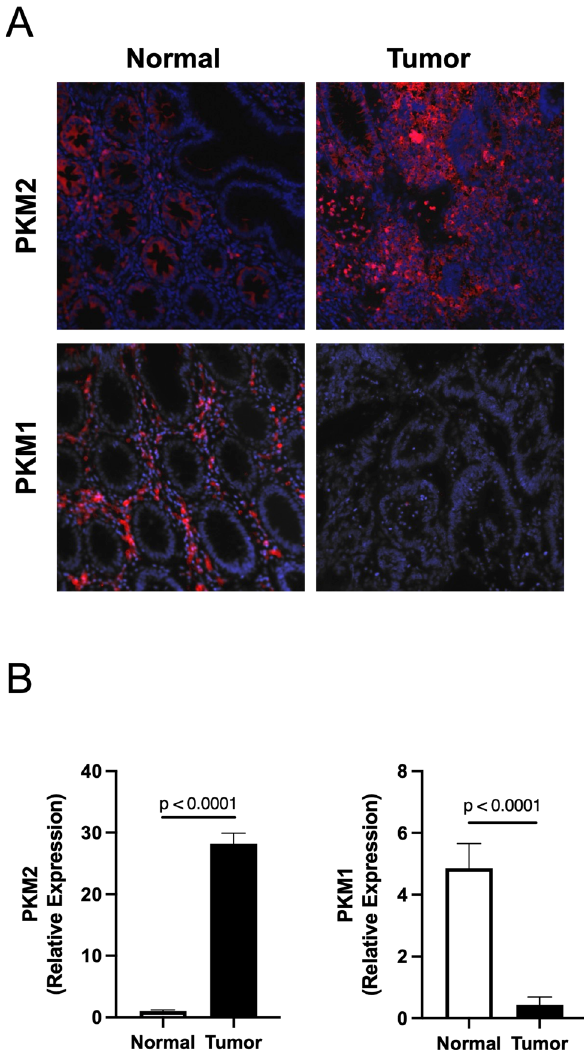
Figure 1. Expression of PKM isoform in human non-cancerous and cancerous colorectal tissues. ( A ) Immunofluorescence staining for PKM2 and PKM1 expression on non-cancerous colorectal tissue and colorectal cancer tissue. ( B ) Quantification of immunofluorescence data with relative expression of PKM2 and PKM1 in each group. Error bars are mean ± SEM for ten independent